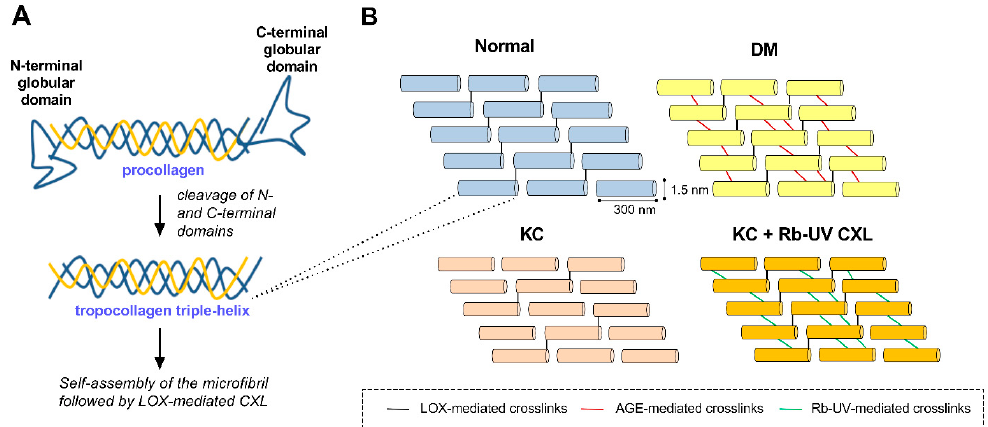
Figure 1. Schematic depicting fibrillar collagen processing and crosslinking in normal, diabetes mellitus (DM),andkeratoconus(KC)microenvironments. ( A )Pro-collagensecretion, cleavage, andself-assembly of tropocollagen to form collagen fibrils. ( B ) Relative distribution of collagen crosslinks presents within normal, DM, and KC corneas. Lysyl oxidase (LOX) catalyzes formation of covalent bonds between lysine or hydroxylysine groups from the C-terminus of one molecule to the N-terminus of an adjacent molecule (black lines). DM has been associated with increased crosslinks mediated by advanced glycation end products (AGEs) (red lines), while KC has been linked to an overall reduction in LOX-mediated crosslinks. Photooxidative corneal crosslinking (CXL) mediated by riboflavin (Rb) is thought to increase the number of collagen crosslinks between fibers (green lines). These enzymatic (e.g., LOX) and non-enzymatic reactions (e.g., AGE- and Rb-UV-mediated) promote the formation of inter- and intramolecular crosslinks between the helical domains of tropocollagen that lead to